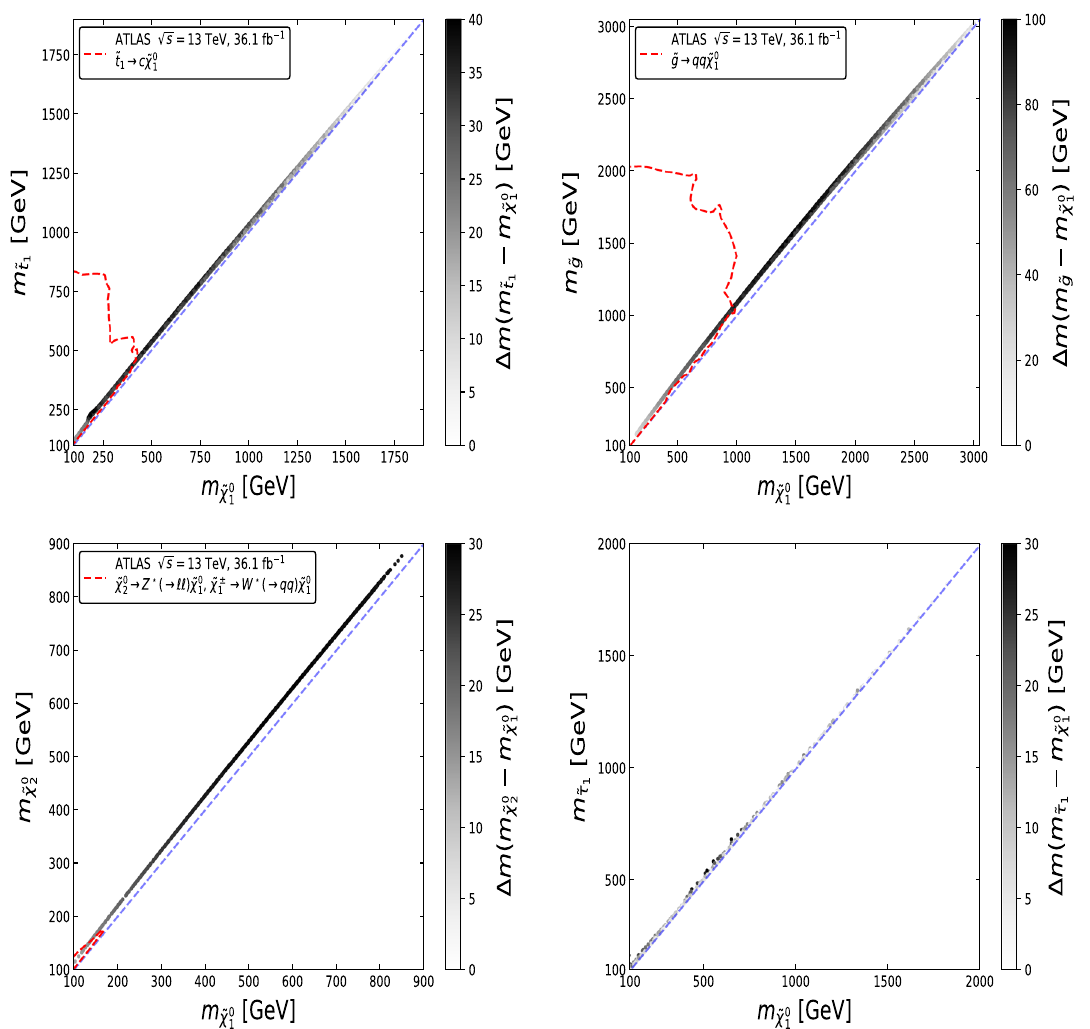
Fig. 1 The samples that satisfy the observed DM relic density, the Higgs mass and vacuum stability conditions are projected on the plane of DM mass and its coannihilating partner mass for bino-stop (top-left panel), bino-gluino (top-right panel), bino-wino (lower-left panel) and bino-stau (lower-right panel) coannihilations. The colormap represents